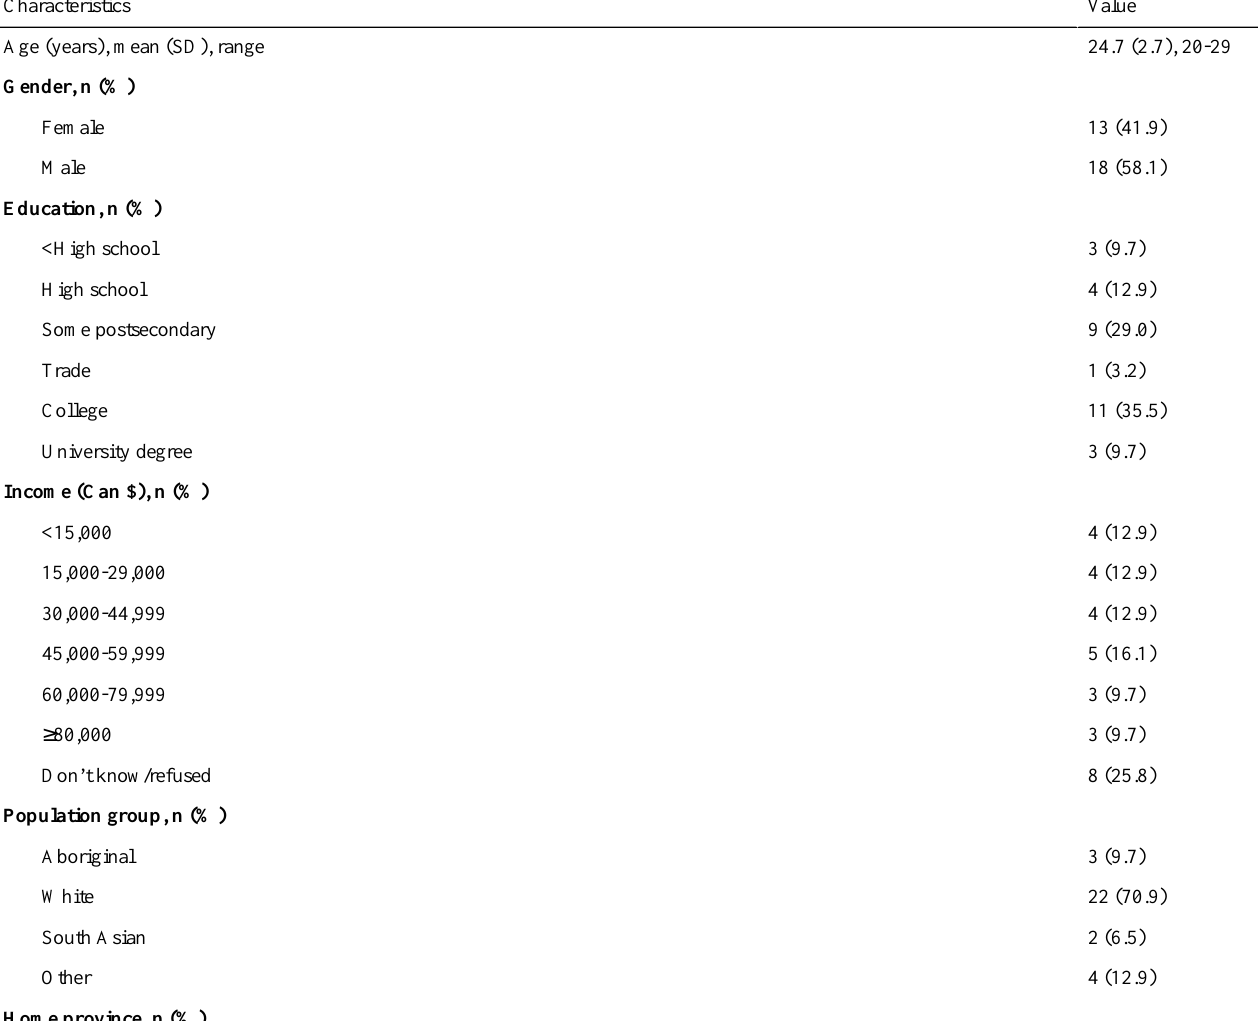
Table 2. Young adult study population